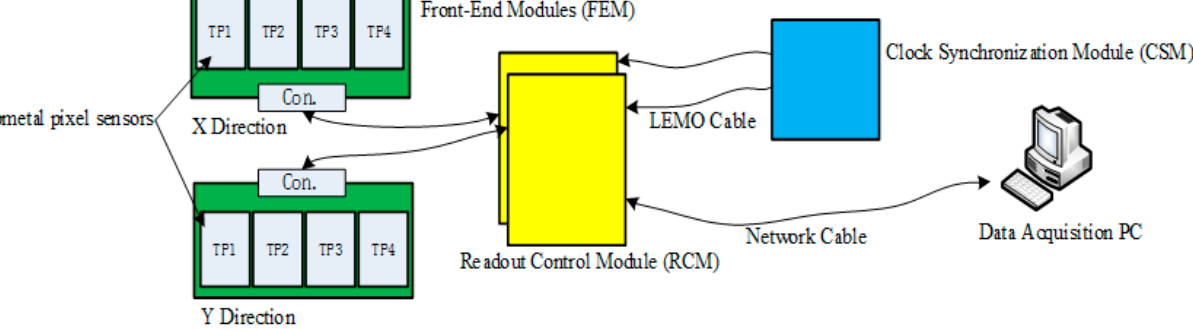
Figure 3. The architecture of the prototype readout electronics.